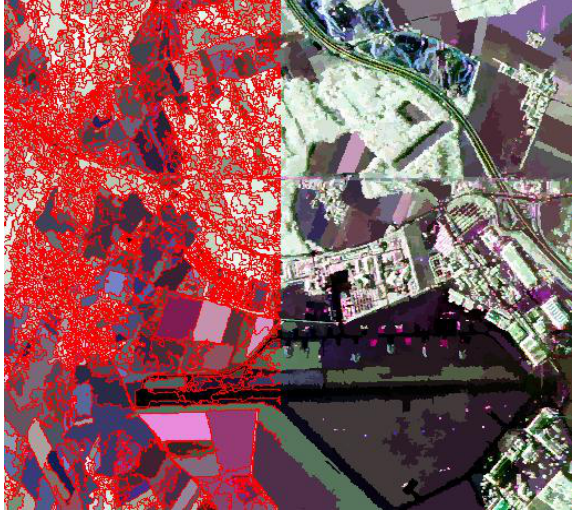
Figure 6. Segmentation result of P-BPT using the homogeneity- based pruning strategy